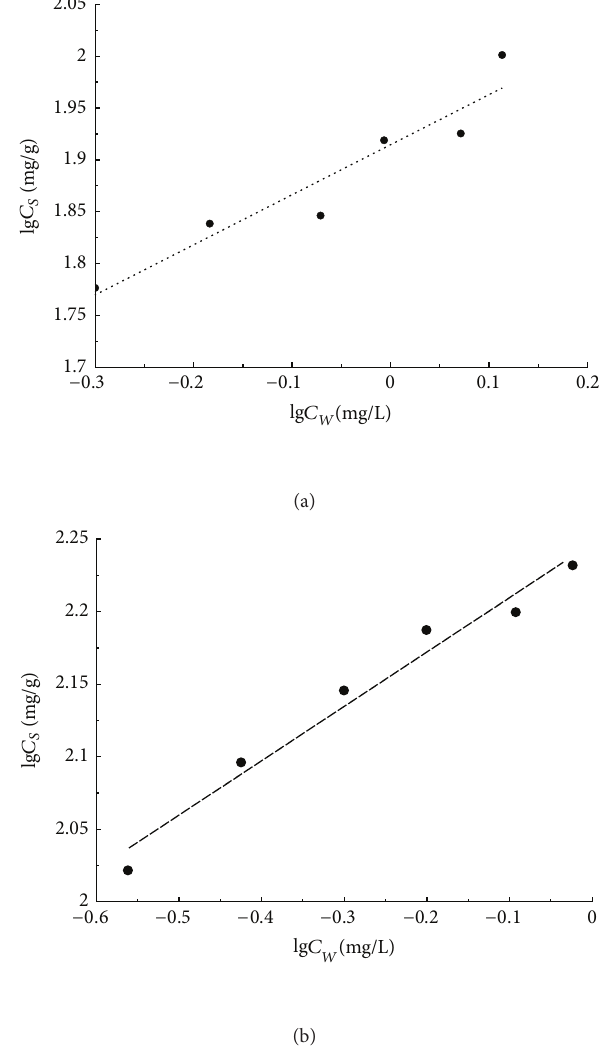
Figure 3: Adsorption isotherms of sulfamethoxazole by MFX adsorbent in 15 ∘ C (a) and 35 ∘ C